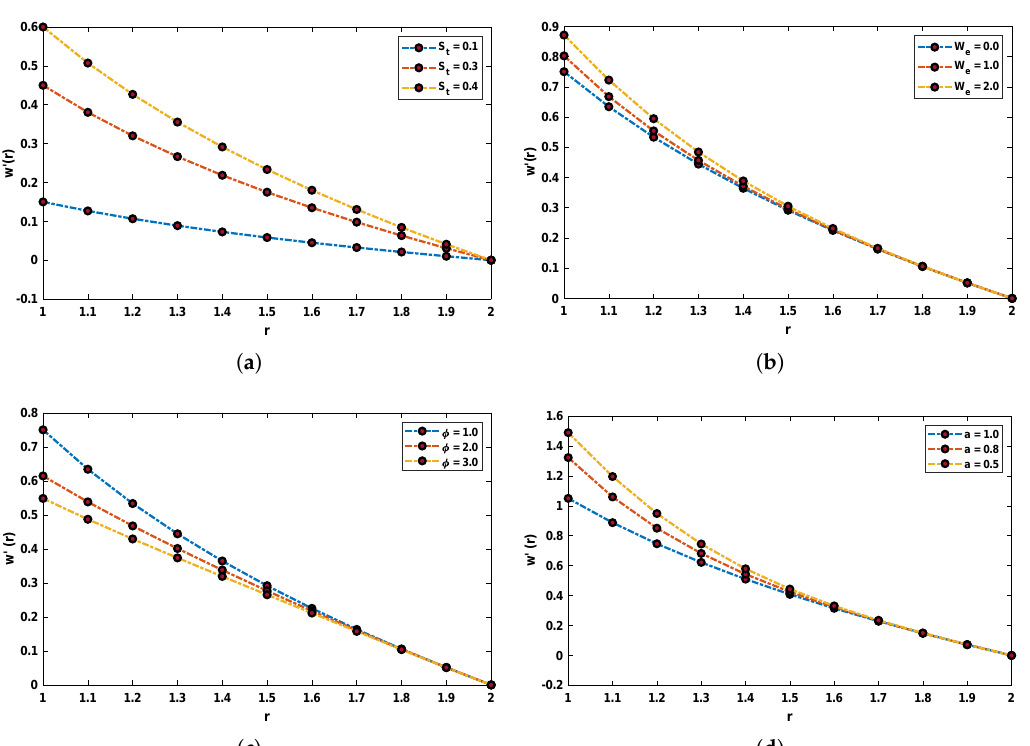
Figure 6. Effect of variations in S t , W e , φ and a on w (cid:48) of the flow of Johnson–Segalman fluid. ( a ) SCENARIO I. ( b ) SCENARIO II. ( c ) SCENARIO III. ( d ) SCENARIO IV.